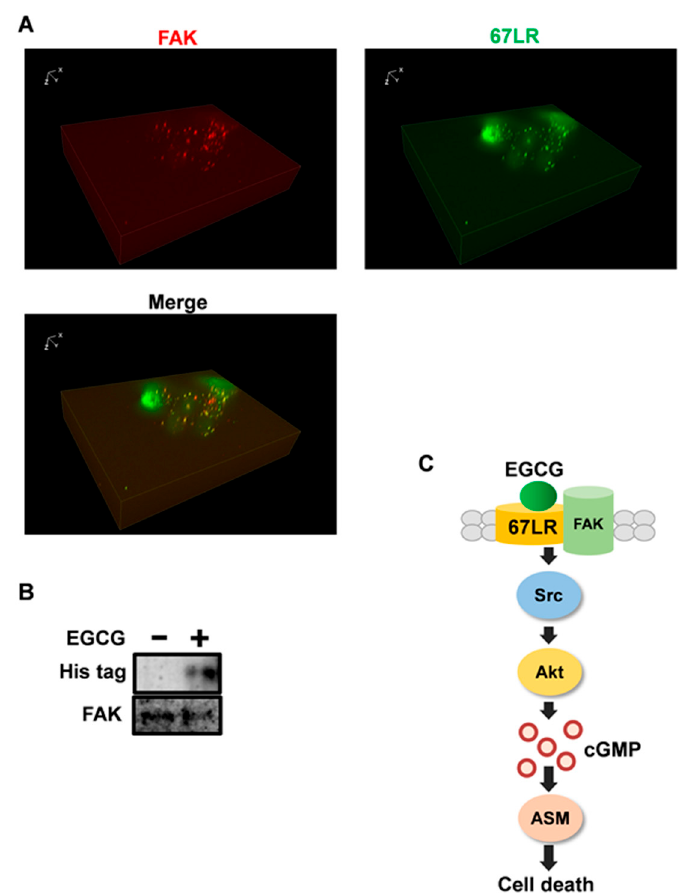
Figure 4. FAK is the adaptor protein of 67LR. ( A ) Immunofluorescence staining for FAK (Red) and 67LR (Green) and Z stack images were determined in HeLa cells using Fluorescence microscopy ( × 40). ( B ) His-tagged 67LR was immunoprecipitated using the anti-FAK antibody after 30 min EGCG (10 µ M) treatment. ( C ) The schematic diagram to summarize the mechanism of EGCG in human multiple myeloma cells. XYZ axis of Z focus image was described above.